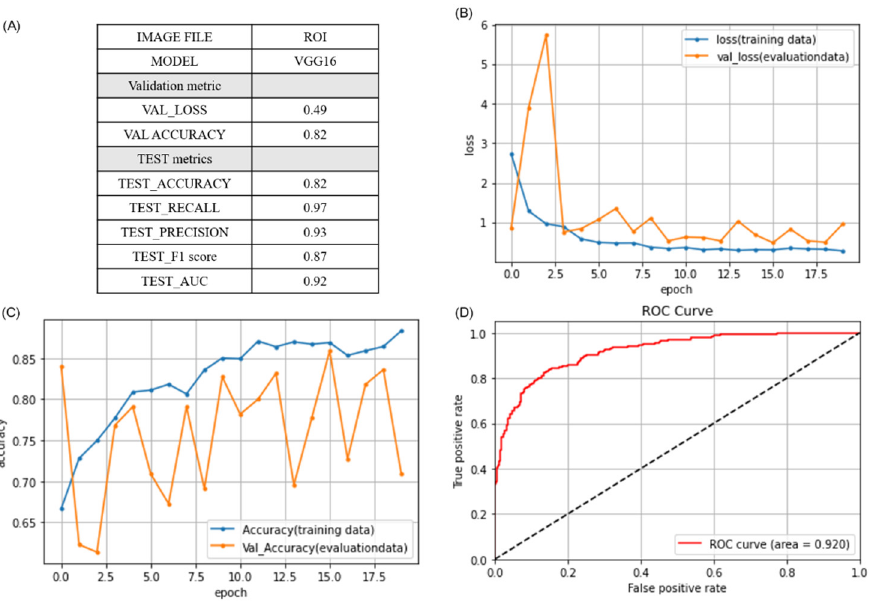
Figure 4. Performance details of VGG16 using ROI images: ( A ) performance metrics used to assess VGG16 using the VAL and TEST datasets; ( B ) loss learning curve of VGG16 indicating that the training data and validation data (VAL) both decreased to a point of stability with a small gap between the two, indicating good model fit; ( C ) accuracy learning curve of VGG16 revealing steady improvement in accuracy in each epoch using the training set during model fitting; ( D ) receiver operating characteristic (ROC) curve and the area under the curve (AUC) plotted using prediction data generated by the trained VGG16 model paired with the corresponding TEST set data, where an AUC of 0.92 indicates good model performance.